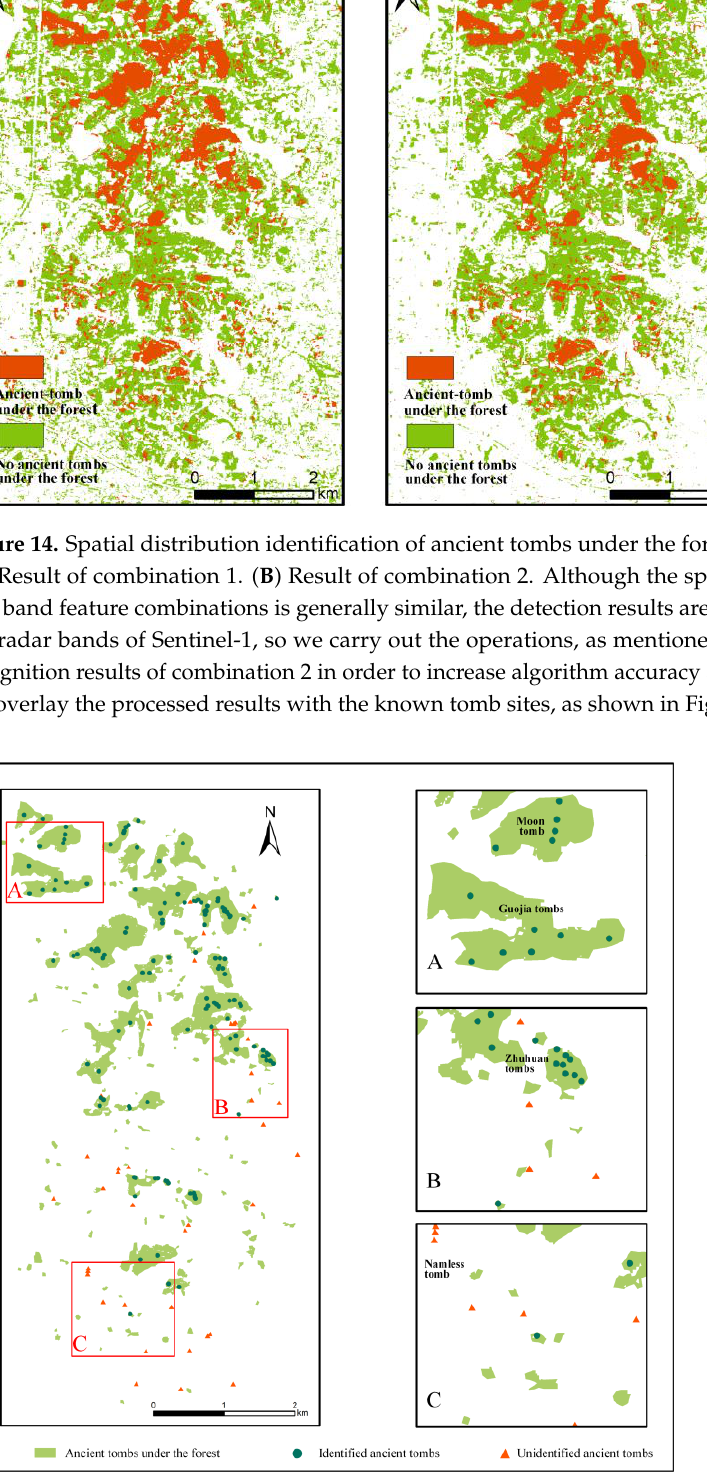
Figure 15. The superimposed comparison of the spatial distribution of the ancient tombs under the forest after smoothing and the confirmed tombs. ( A ) It is the area where ancient tombs are large. ( B ) It is the area where ancient tombs are relatively concentrated. ( C ) It is the area where ancient tombs are scattered.